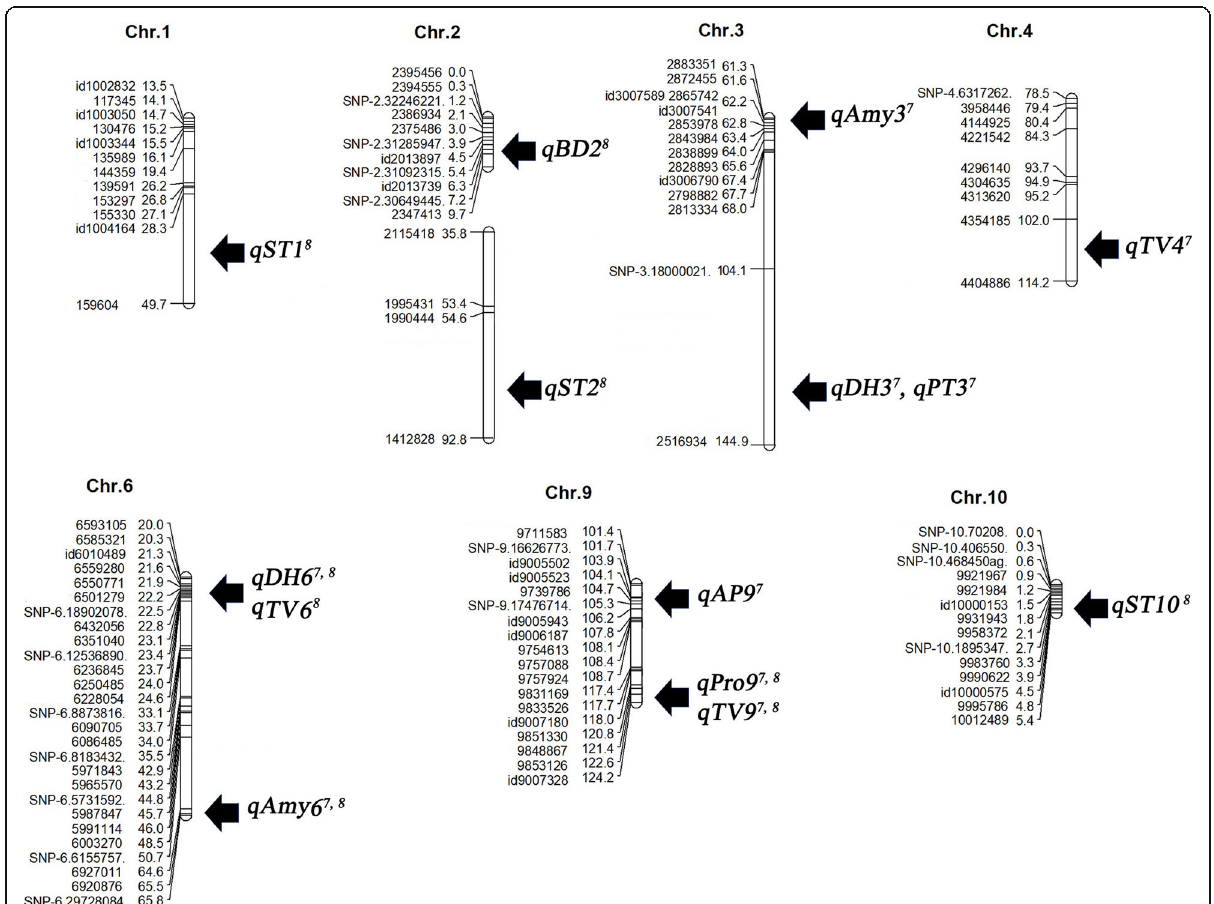
Fig. 2 Location of QTLs for eating and cooking quality traits detected in the linkage map on chromosomes 1, 2, 3, 4, 6, 9 and 10. The marker names and linkage distances are shown on the right of each chromosome, and each QTL is presented to the right of the linkage map. Superscripts 7 and 8 indicate the years 2017 and 2018, respectively, in which the QTL is